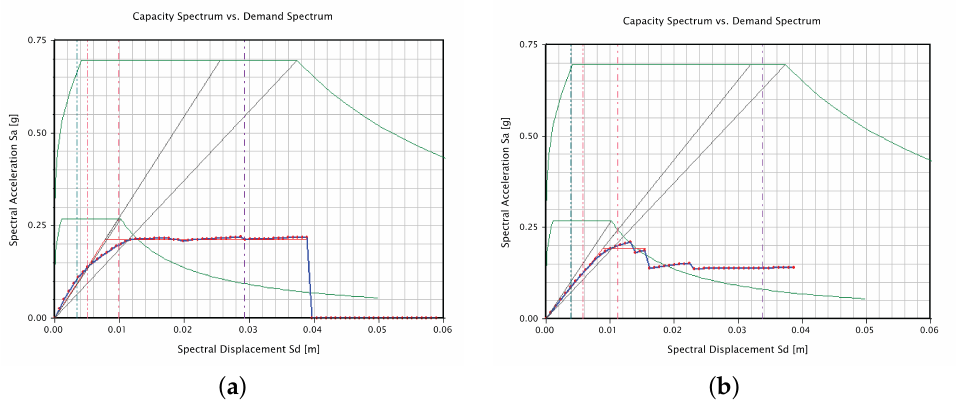
Figure 16. Seismic capacity and seismic demand curves for the SDOF equivalent system of the main building. Displacements in the abscissae are in meters, accelerations in the ordinates are in terms of gravitational acceleration, i.e., 1 corresponds to 9.8 m/s 2 . ( a ) Seismic forces in direction X. ( b ) Seismic forces in direction